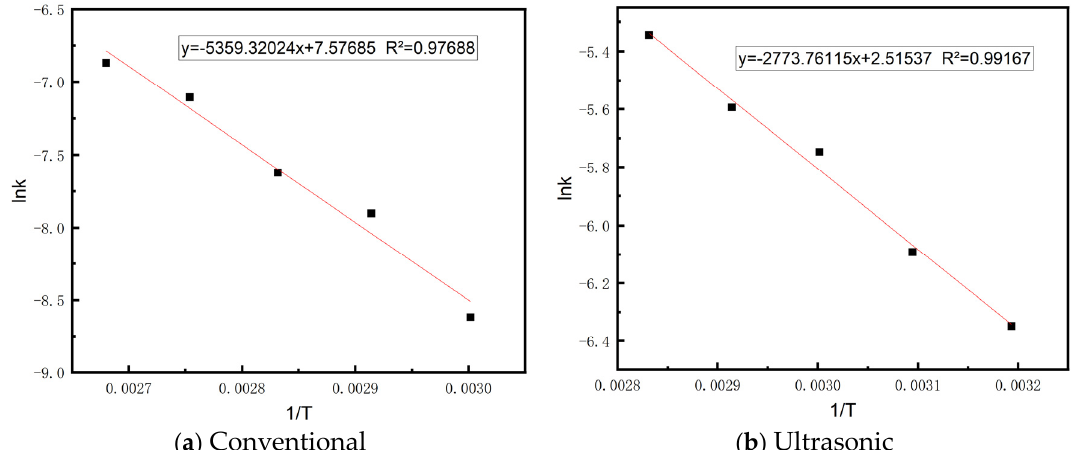
Figure 13. The relation between lnk and 1/ T .